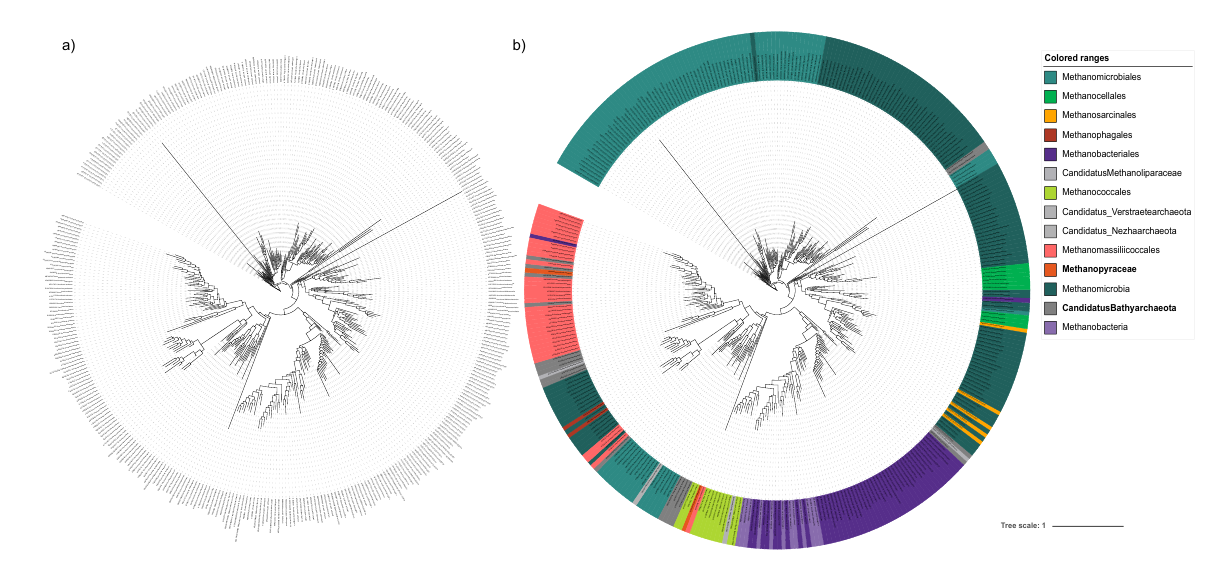
Figure 4. Phylogenetic trees inferred by the workflow of PhyloFunDb pipeline used to create a mcrA gene database. ( a ) Inferred tree created as output of PhyloFunDb; ( b ) after manual curation of the sequence classification, several sequences coming from environmental studies had their classification